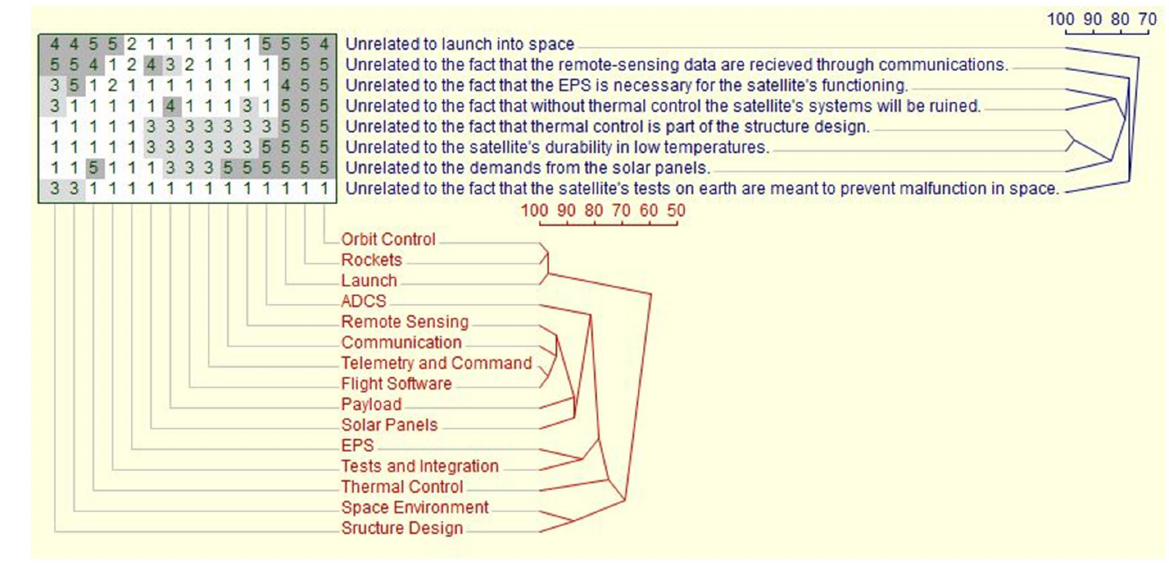
FIGURE 11 Adam’s post repertory grid. The left side constructs are truncated for the sake of